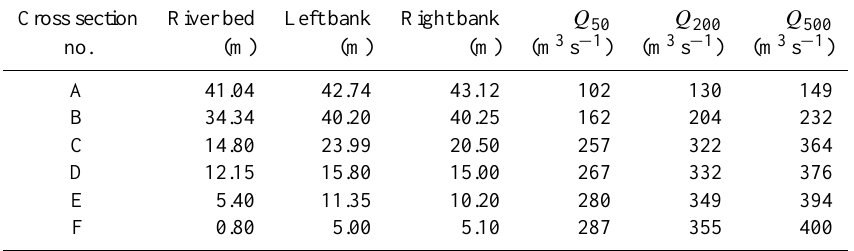
Table 1. Hydraulic cross section data (from Provincia di Genova, 2002). Cross